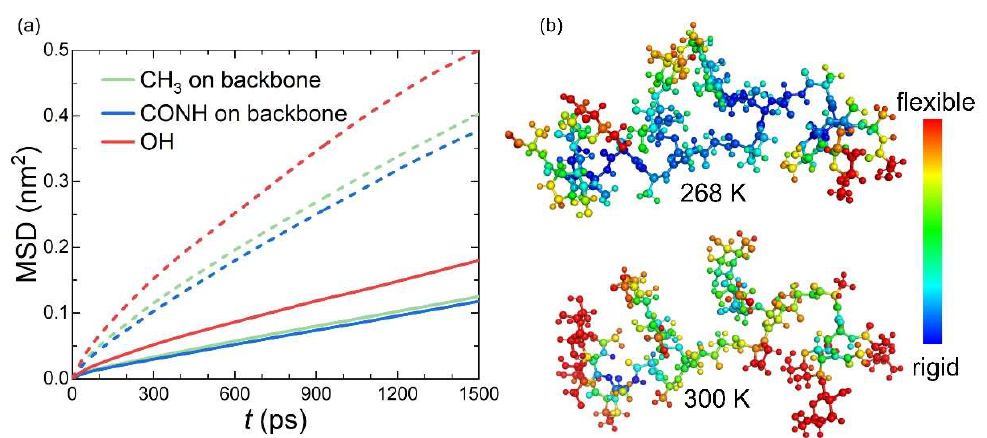
Figure 9. The disaccharides of AFGP8 are more flexible than its backbone. ( a ) Mean squared displacement of methyl groups on backbone (green lines), amide groups (blue lines) and hydroxyl groups (red lines) at 268 K (solid lines) and 300 K (dashed lines). ( b ) Flexibility (B factors) of AFGP8 at 268 and 300 K.